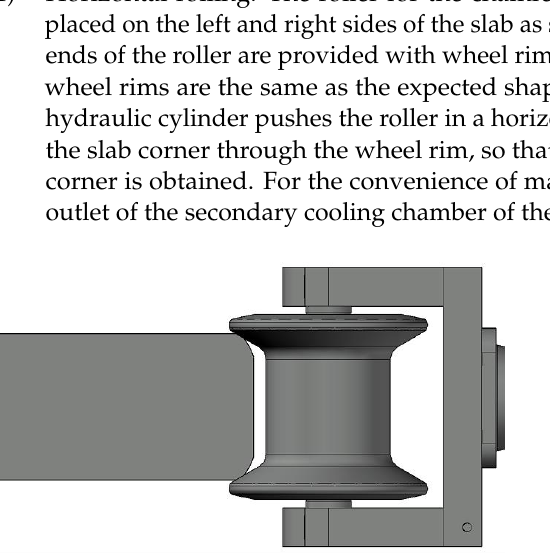
Figure 3. Schematic diagram of horizontal rolling at the chamfered slab corner.